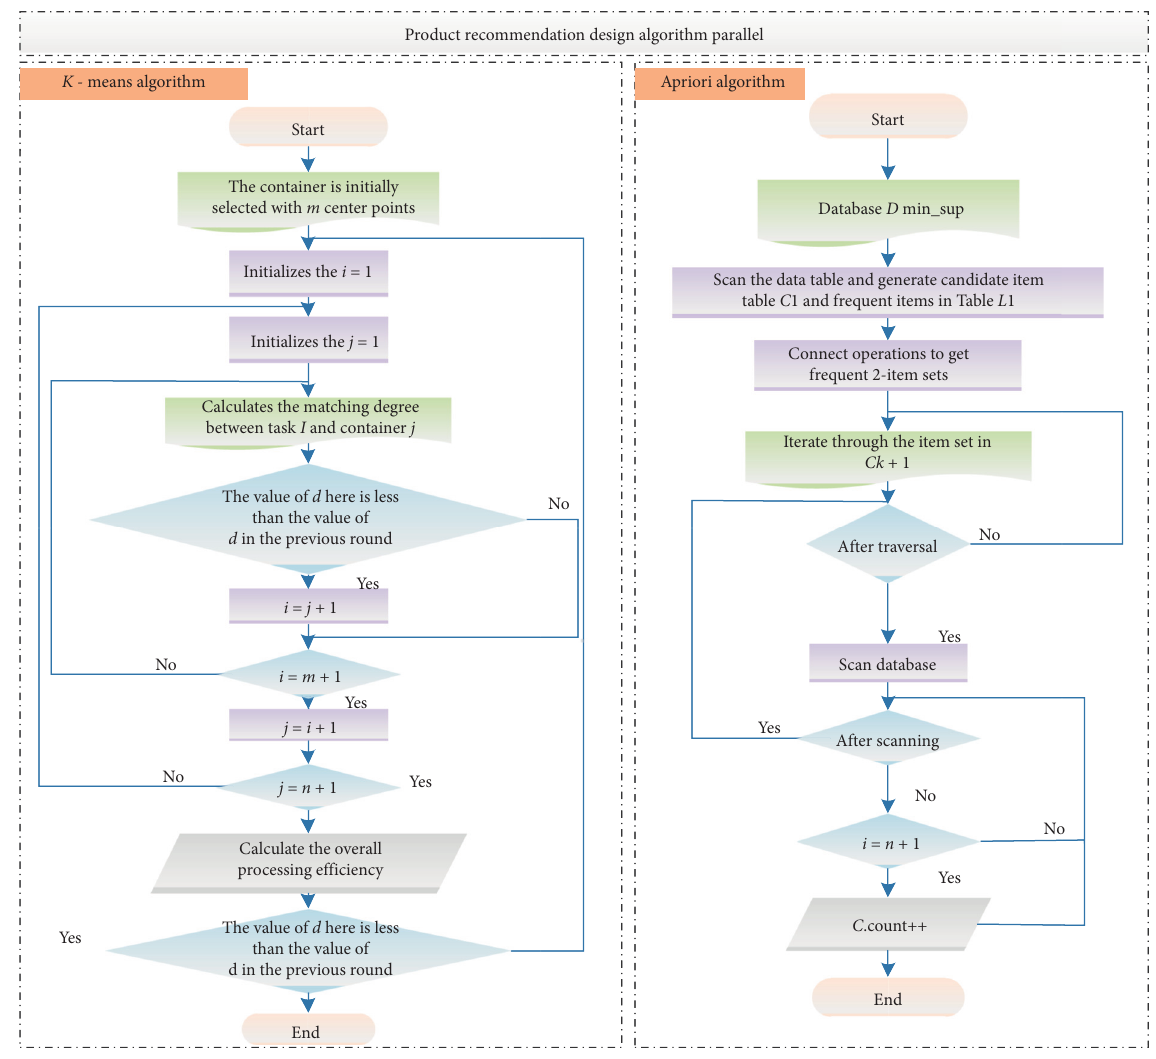
Figure 4: K -means and Apriori’s parallel algorithm for commodity